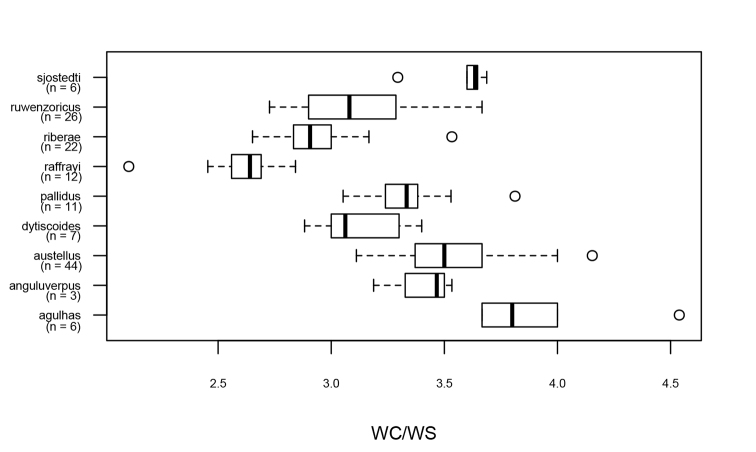
The ratio between width of the metacoxal plate and metasternal wing (WC/WS) in the A.
raffrayi group (incl. specimens of both sexes). Thick black line inside boxes represents medians, left and right box borders 25th (Q1) and 75th (Q3) percentiles respectively. Whiskers were calculated with the boxplot.stats function in R using the default coefficient value of 1.5 (drawn to the highest and lowest value within 1.5*IQD (Inter Quartile Distance = Q3-Q1) away from the 75th and 25th percentiles respectively). Note that this character fully separates A.
raffrayi from A.
pallidus.